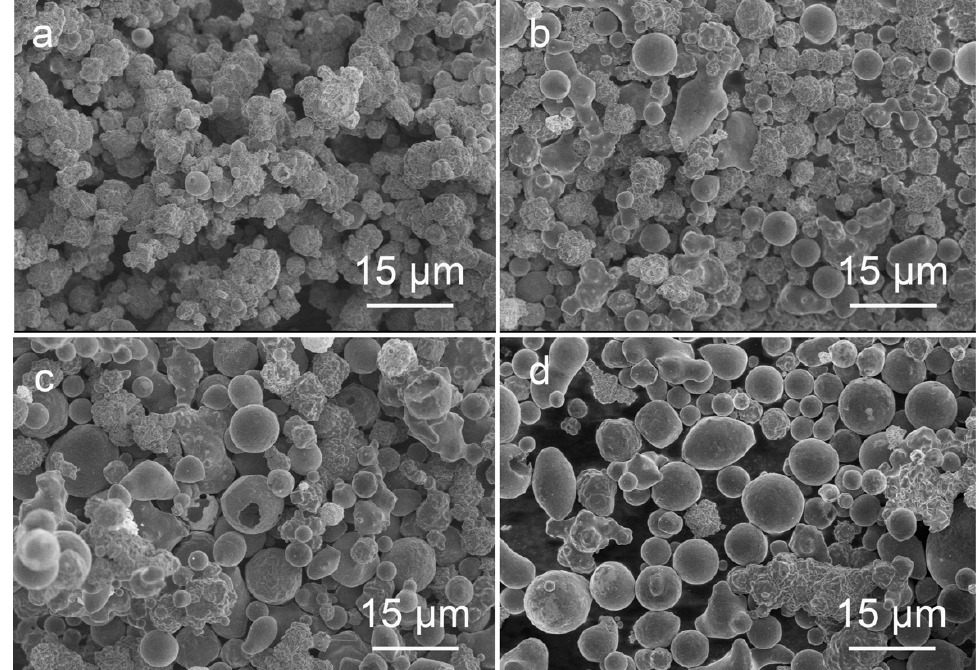
Figure 3. SEM images of samples irradiated for 20 min at different laser energy densities: ( a ) 21.0 J/cm 2 , ( b ) 52.4 J/cm 2 , ( c ) 72.3 J/cm 2 , and ( d ) 83.9 J/cm 2 .